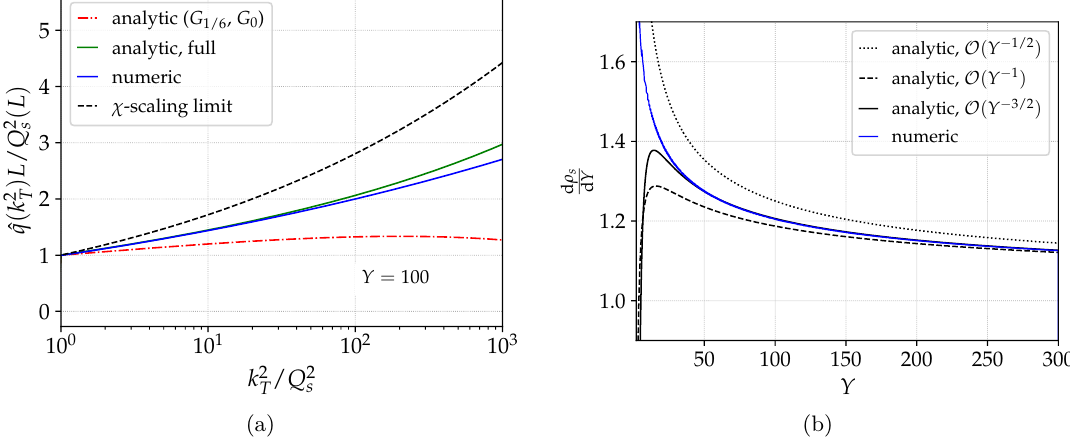
Figure 8. (Left) The dimensionless parameter ˆ q ( L, k 2 k 2 /Q 2 including the first three terms in the leading edge expansion. (Right) Comparison between s T the numerical calculation of ˙ ρ s ( Y ) and its asymptotic